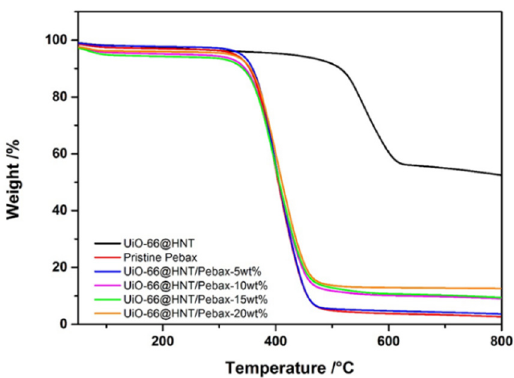
Figure 7. TGA curves of UiO-66@HNT and UiO-66@HNT/Pebax membranes.